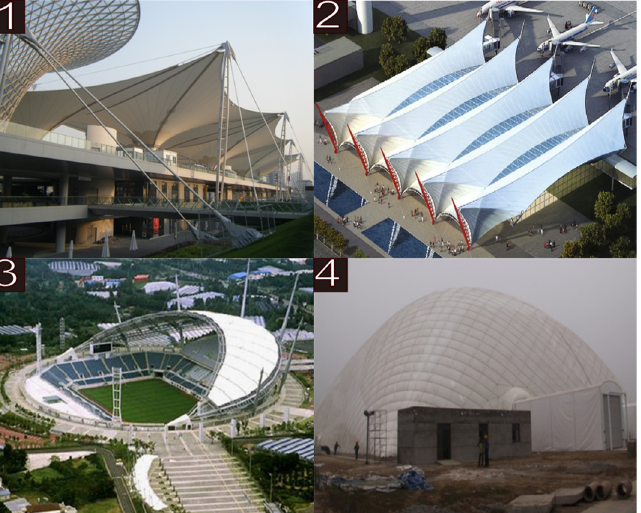
Figure 3. The main types of membrane structures: 1. Tensioned membrane structure, 2. Cable–membrane structure, 3. Skeleton membrane structure, 4. Inflatable membrane structure [12,30–32].